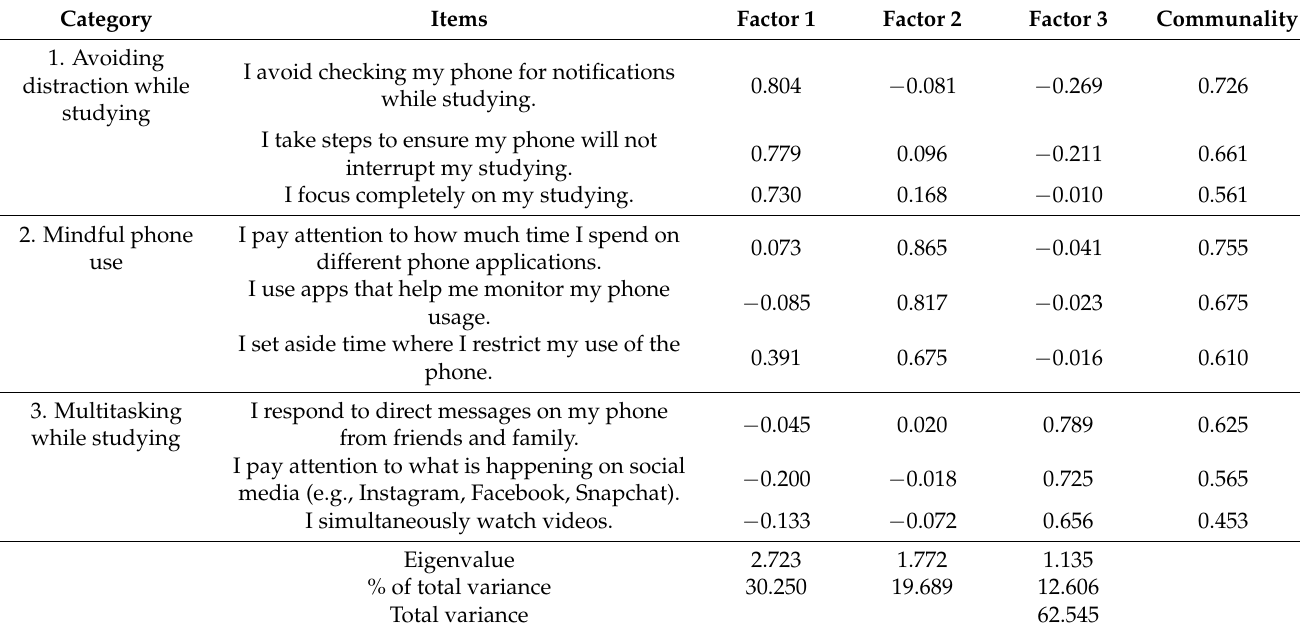
Table 5. Factor analysis table for common phone practices.